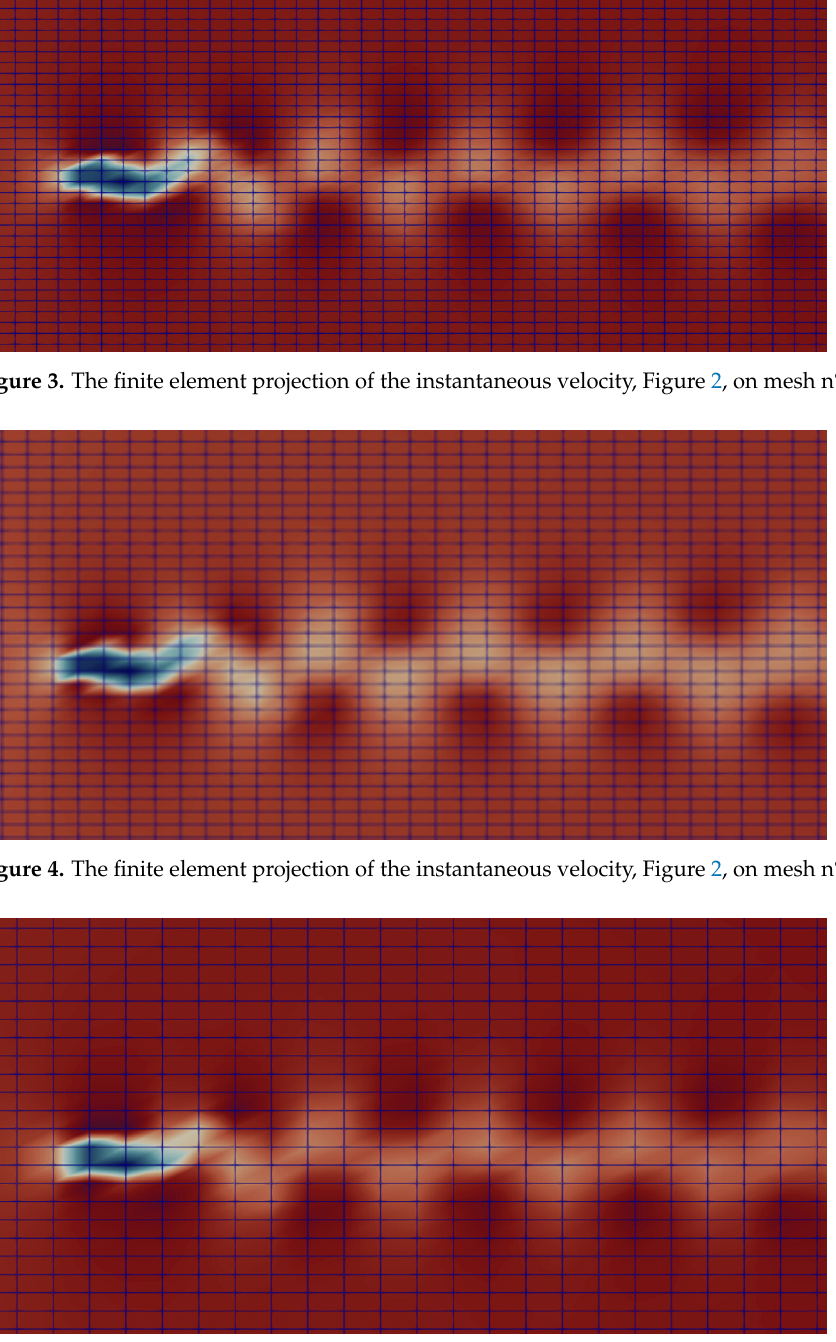
Figure 5. The finite element projection of the instantaneous velocity, Figure 2, on mesh n°3 in Table 1. The architecture of the VAE is very classical; it is formed of two convolution layers and two maxpool layers followed with two fully connected layers. A nonlinear activation function is considered between the layers. The Adam optimizer [46] is considered for the optimization of the parameters Φ and θ by a stochastic gradient descent. The learning rate is set equal to 0.001. The dimension of the random latent space is set equal to 3. The batch size is set equal to 20. We train the VAE during 1000